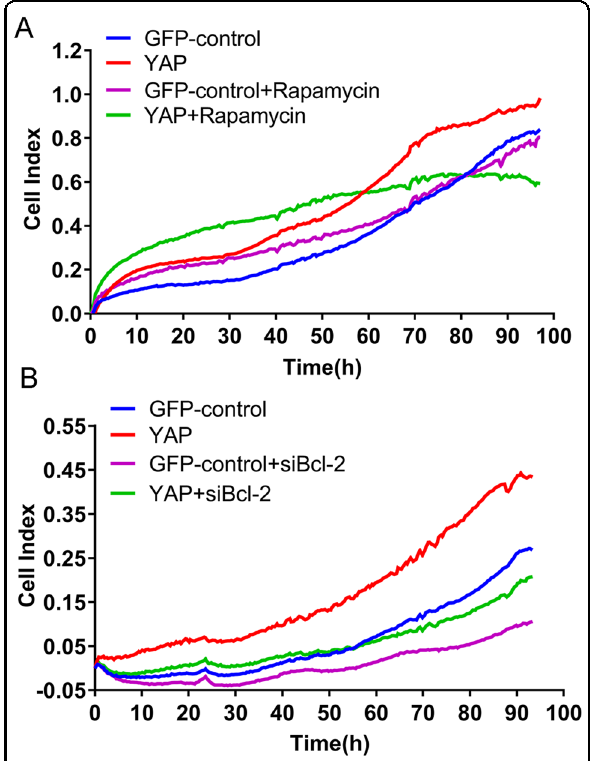
Fig. 5 Activating autophagy can inhibit the YAP-induced CRC progression. A The YAP-overexpressing (YAP) and control (GFP- control) SW620 cell lines were treated with rapamycin (50 µg/mL) for 90 h, and cell growth was then monitored by RTCA. B The YAP- overexpressing (YAP) and control (GFP-control) SW620 cell lines were transfected with 100 nM of Bcl-2-speci fi c siRNA or NC siRNA for 90 h; cell growth was then monitored by